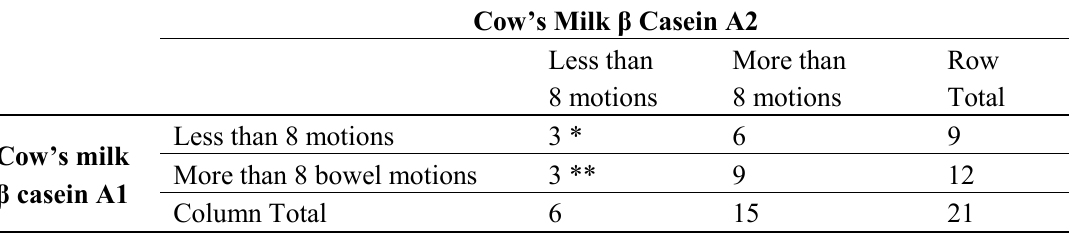
Table 3. Clinical outcomes for participants who completed all 3 conditions of Trial 2: